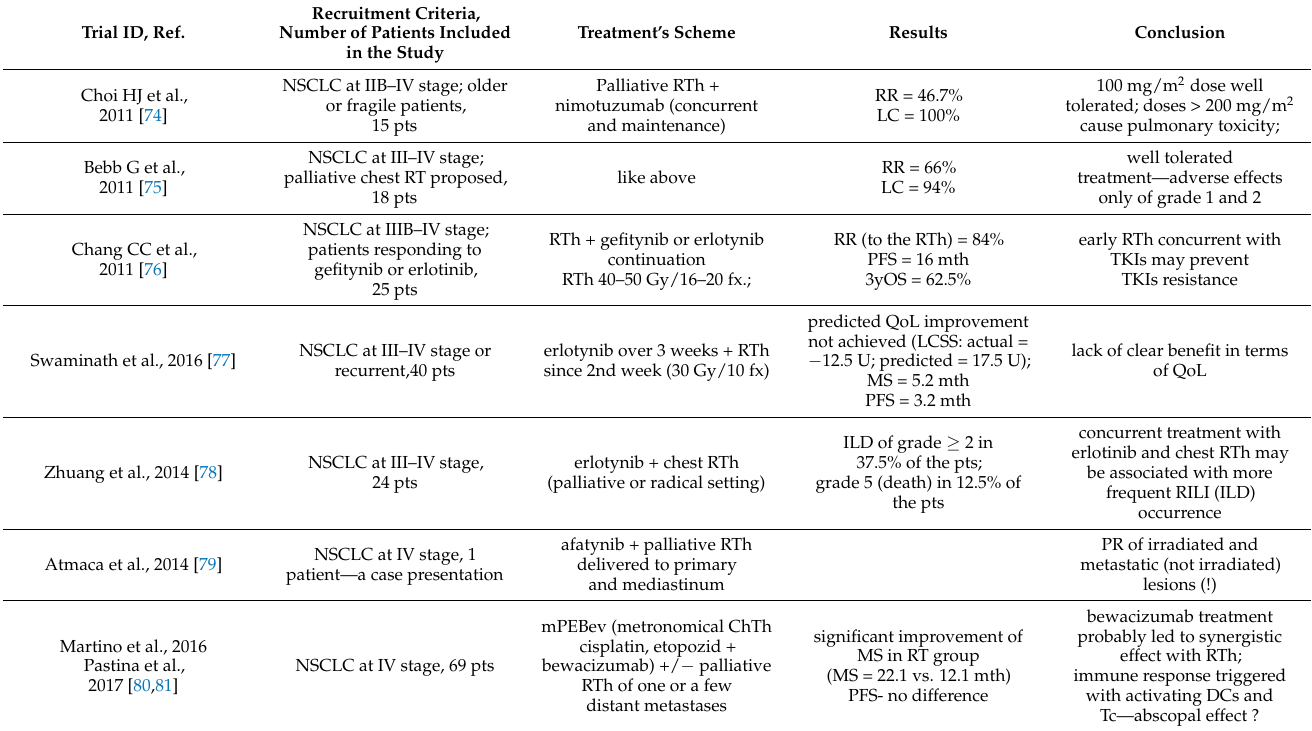
Table 2. Targeted therapies combined with radiotherapy in palliative setting—results of the studies. Trial ID,